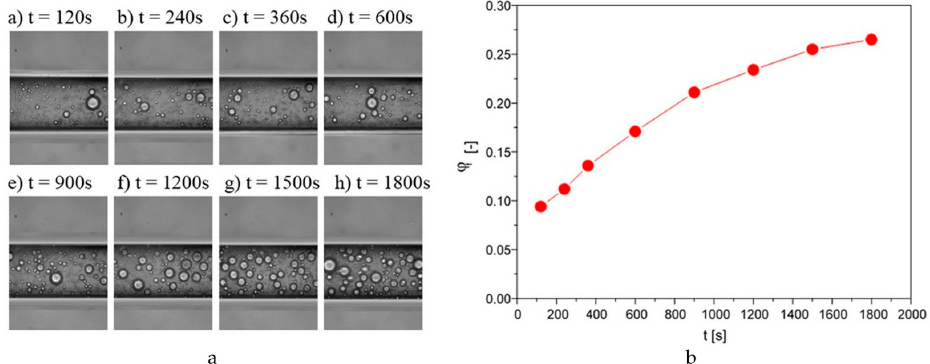
Figure 3. ( a ) Sequence of images taken during the flow of an emulsion with a concentration of 0.05 at a flow rate of 5 µ L/h. ( b ) Changes in the droplet density ratio during the flow through the capillary for the emulsion with a concentration of 0.05 at a flow rate of 5 µ L/h.